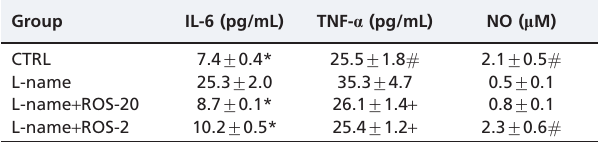
Table 2 - Inflammatory parameters of the experimental groups at the end of the experiment.